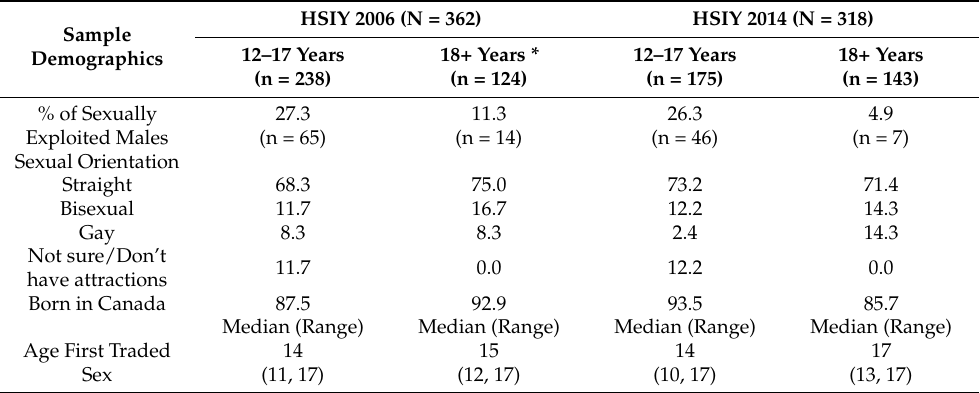
Table 1. Description of